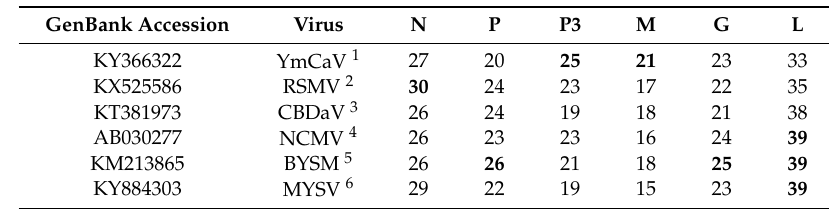
Table 4. Amino acid sequence identities (%) of bean-associated cytorhabdovirus (BaCV) proteins compared with their homologs of other cytorhabdoviruses.